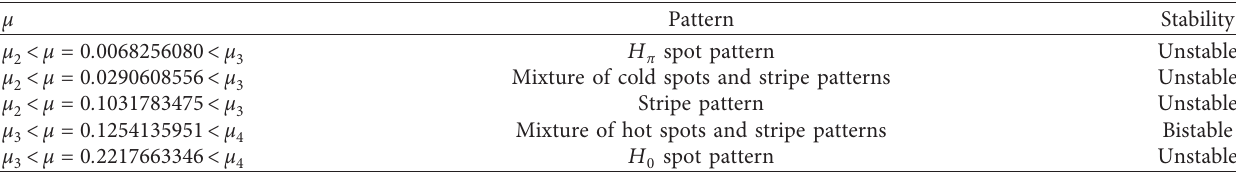
Table 3: Pattern selection of model (4).